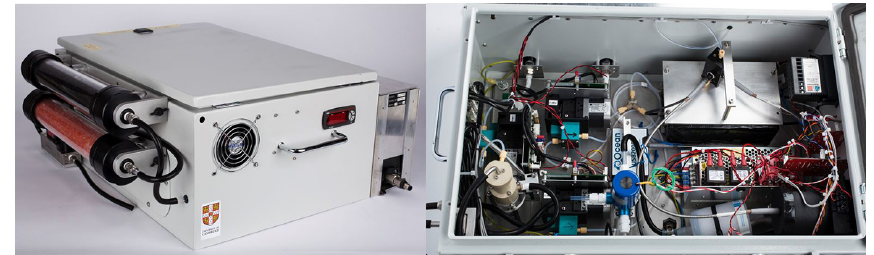
Figure 2. The exterior (a) and interior (b) of the new OPROSI. All components shown are attached and integrated into, or onto, a portable box (60 × 50 × 25cm) to allow easier deployment for field